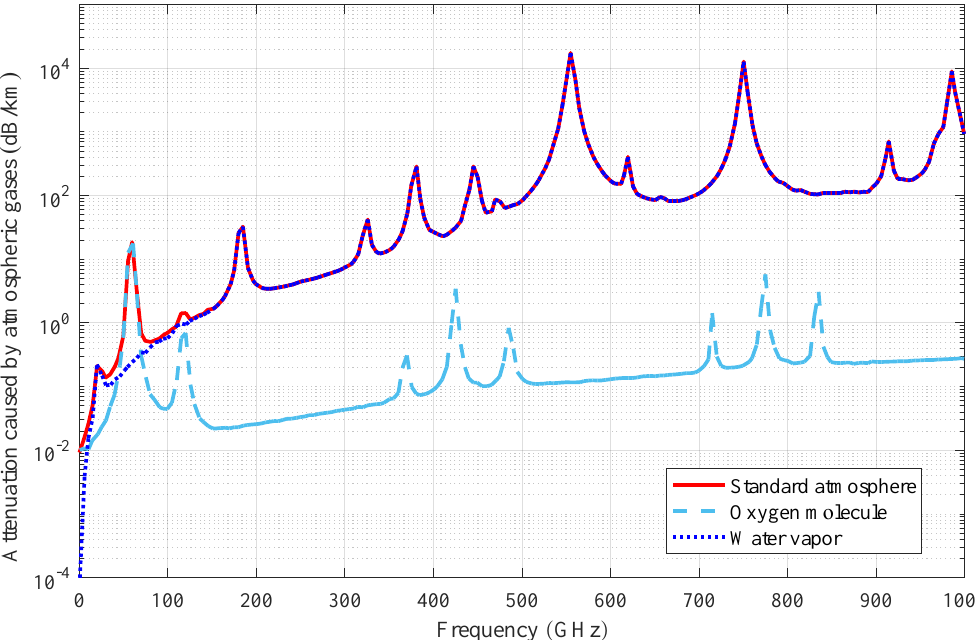
Figure 1. Attenuation caused by the typical standard atmosphere, comprising the individual influences of oxygen molecules (cyan curve) and water vapor (blue